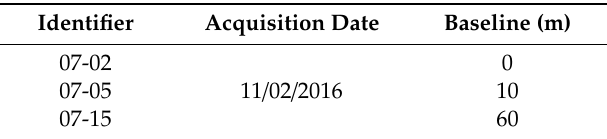
Table 3. The baseline information for the InSAR